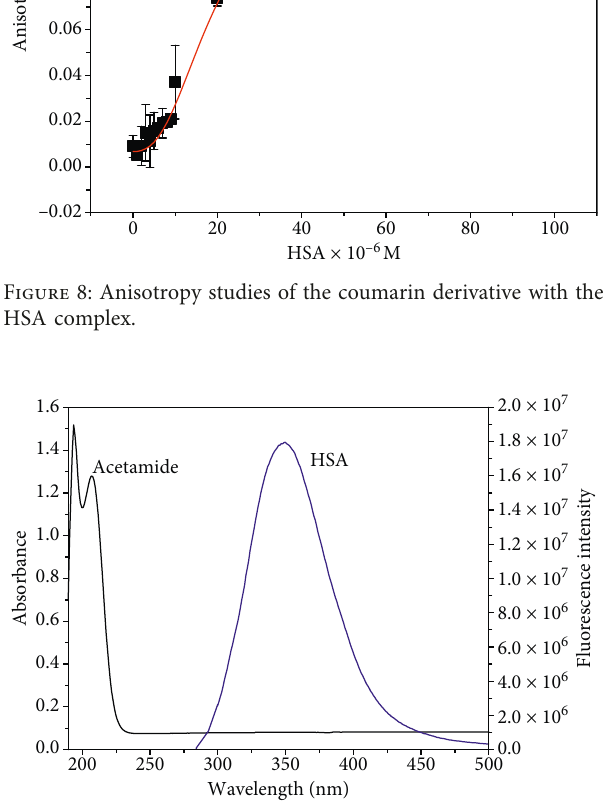
Figure 9: The distance between HSA and coumarin